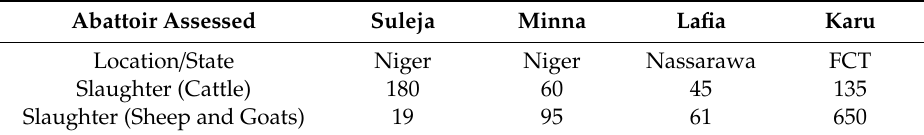
Table 2. Average daily number of animal slaughters from the study sites.